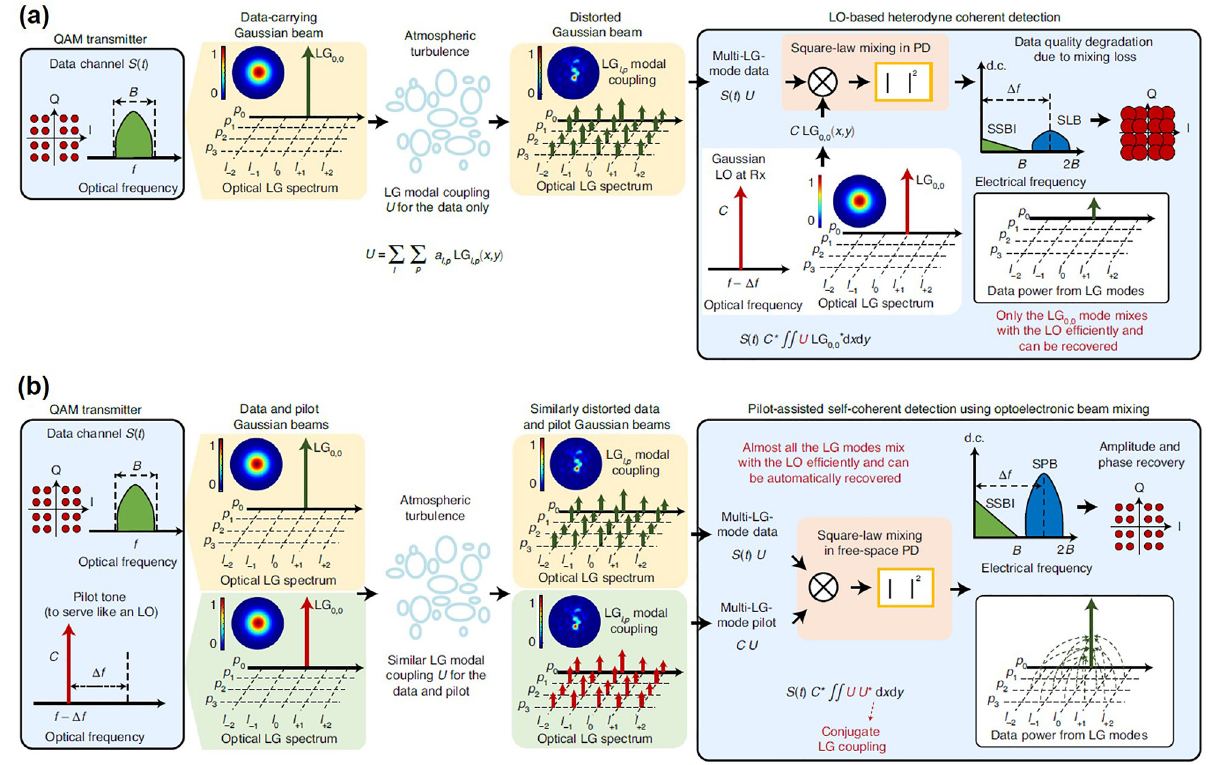
Figure 25: Concept of simultaneous amplitude and phase recovery of data in turbulent free-space optical communication links. (a)Theperformanceofcoherentdetectioncouldbesignificantlydegradedbyturbulence-inducedLGmodal-couplingeffects.(b)Pilot-assisted self-coherent detection could automatically compensate for the turbulence-induced LG modal-coupling effects [134]. Reprint permission obtained from [134].